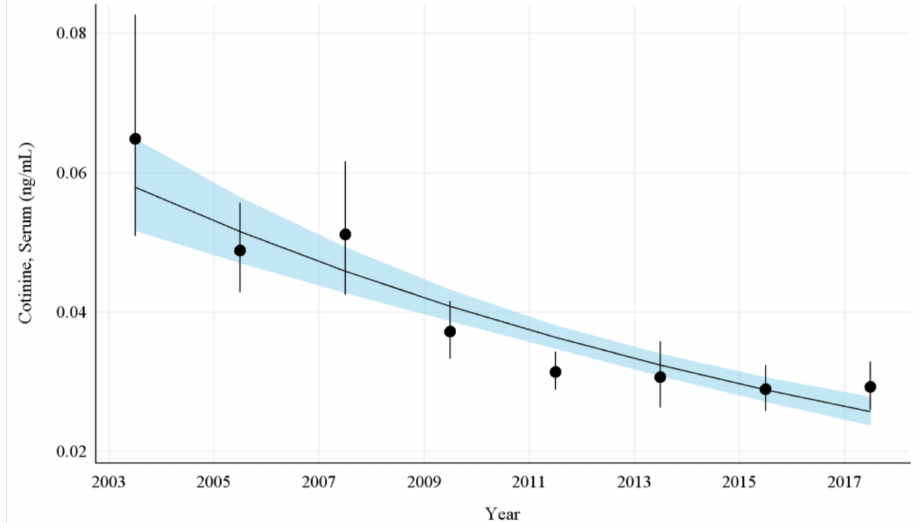
Figure 1. Sample-weighted geometric means (GM) and 95% confidence intervals (CI) of serum cotinine for all U.S. nonsmokers aged ≥ 3 years from 2003 to 2018. The data are plotted at the approximate midpoint of each study interval for eight separate NHANES survey cycles. The points represent the GMs and the vertical lines represent 95% CIs of the GMs for each survey cycle. The black trend line represents the weighted log-linear regression line and the shaded area is the 95% CI of the regression